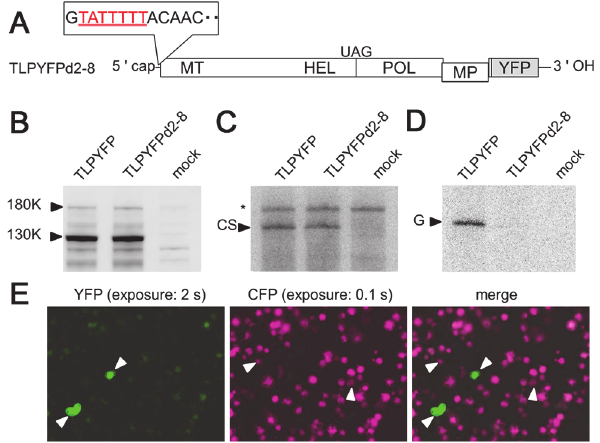
Fig 7. Enhanced variation in progeny accumulation demonstrated experimentally. (A) Structure of TLPYFPd2 – 8. The deleted region (nt 2 – 8) is shown by underlined red letters. (B – D) Characterization of TLPYFPd2 – 8 using an in vitro translation – replication system. (B) Western blotting of the translation products of TLPYFPd2 – 8 and parental TLPYFP without the 5 0 -UTR mutation. Arrowheads indicate the positions of the two replication proteins synthesized by translation: 130K and its stop codon read-through product 180K. (C) RNase protection assay (RPA) to detect complementary-strand RNA. An arrowhead indicates the position of the protected RNA originating from complementary-strand RNA (CS). An asterisk indicates the position of an unintended RNA band that originates from the minor complementary transcripts generated during probe preparation. (D) RPA of genomic RNA. An arrowhead indicates the positions of the protected RNAs originating from the genomic RNA (G). (E) Co-inoculation of TLPYFPd2 – 8 and TLPCFP. The images were obtained at 40 hpi and processed in the same way as described in Fig. 1. Note that the exposure period differs for the detection of YFP and CFP. Arrowheads indicate singly infected